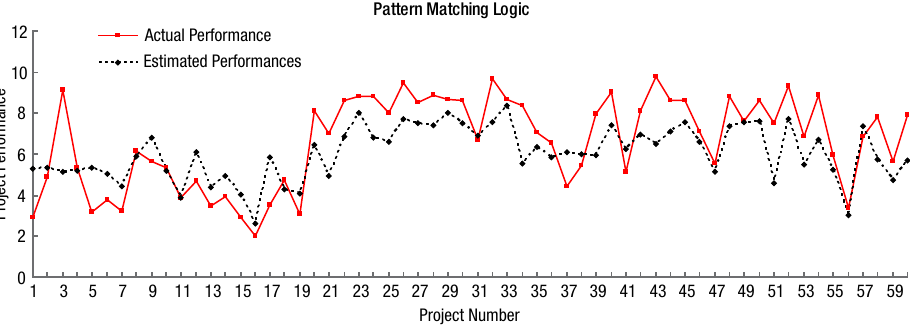
Fig. 2. Plots of the actual versus fitted values of Model 4 for the 60 out-of-sample projects